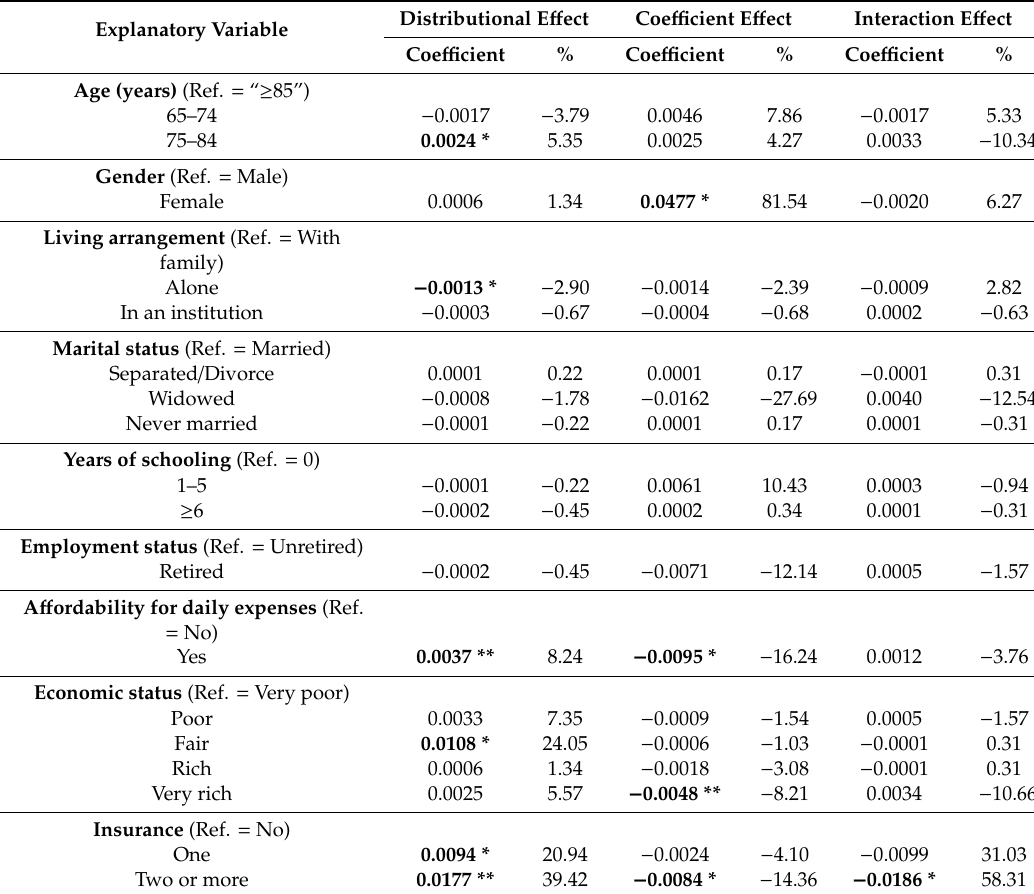
Table 3. Distributional and coe ffi cient e ff ects of explanatory variables on the change in perceived accessibility to